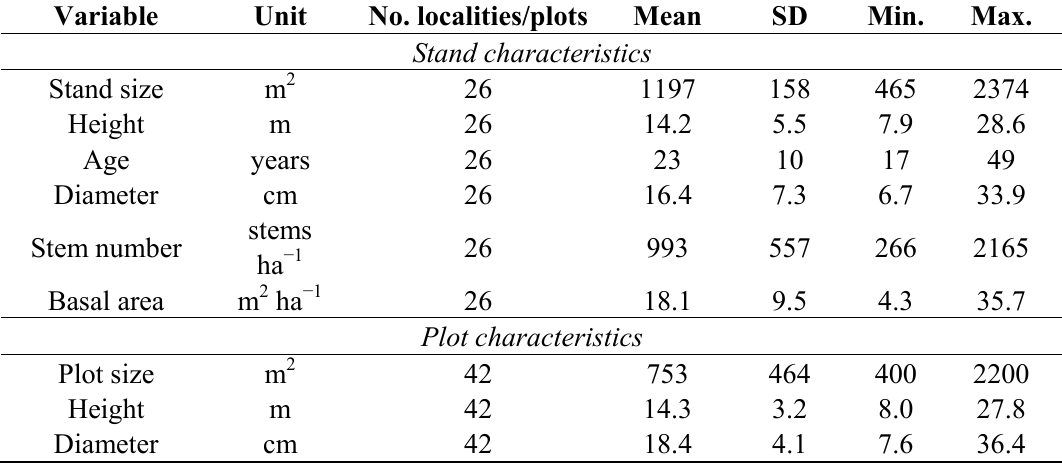
Table 1. Summary statistics for height, age, diameter, stem number and basal area for stands and